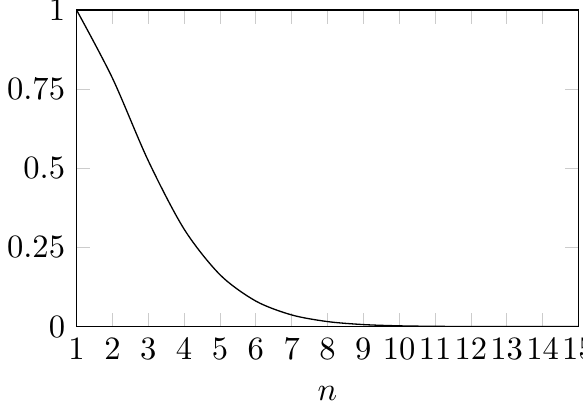
Fig. 2. Volume ratio of the unit sphere to the unit cube in n dimen- sions as a continuous function of n Fig. 2: Volume ratio of the unit sphere to the unit cube in n dimensions as a continuous function of n